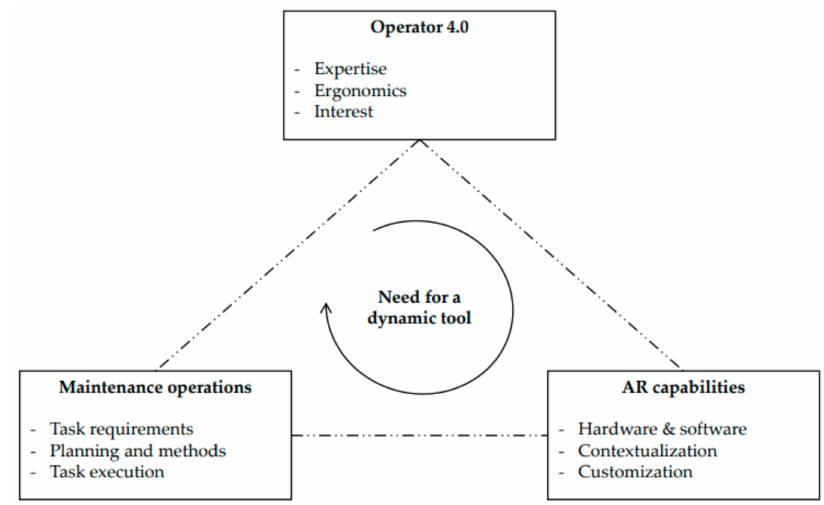
Figure 1. Focus points of the adaptive architectural